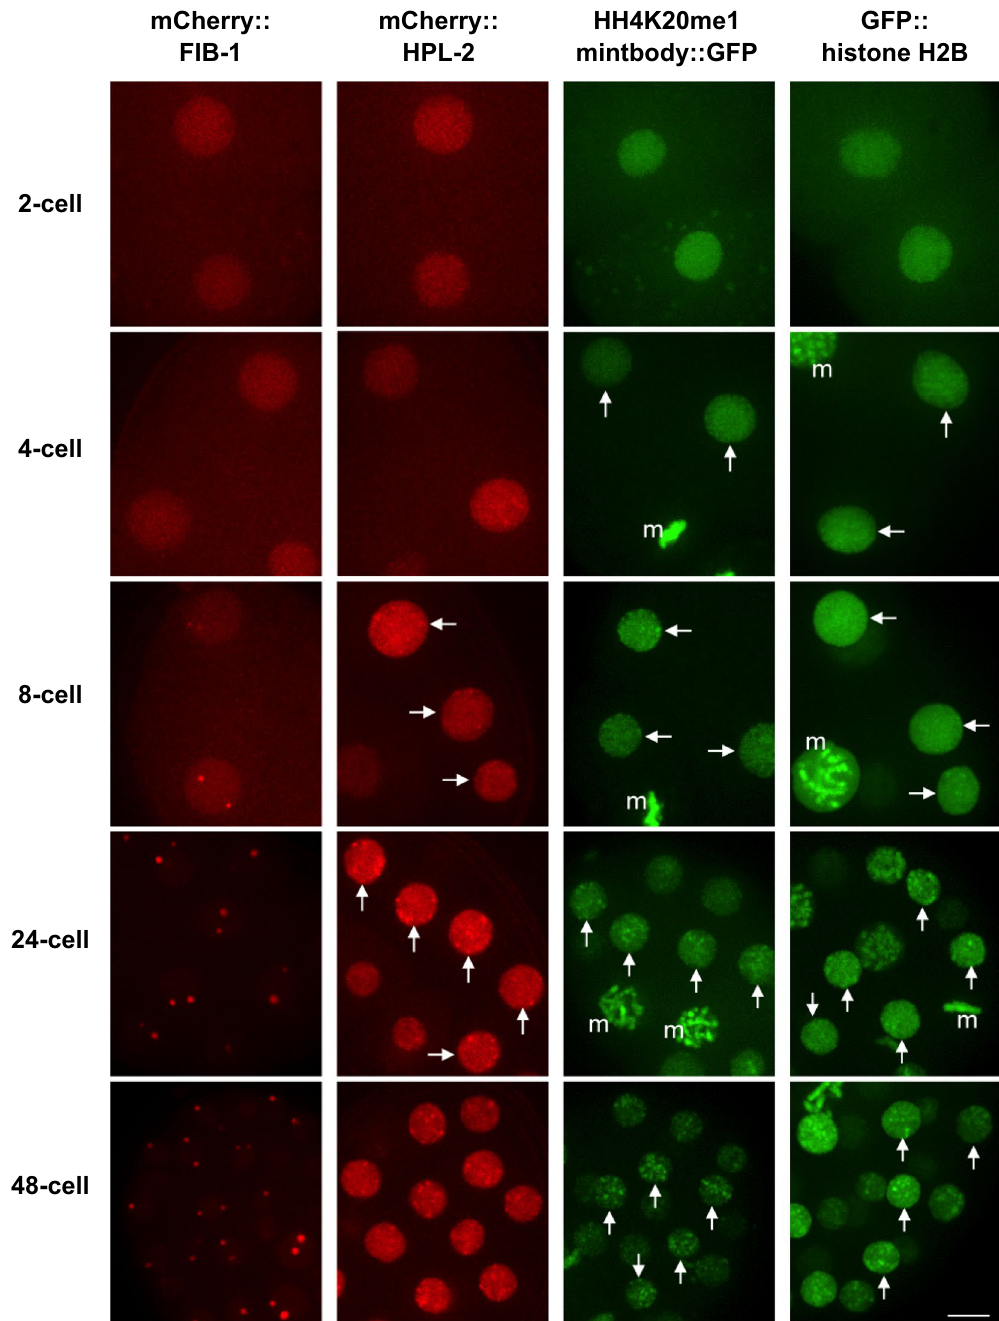
Figure 4. Live imaging of chromosomal domain formation during early embryogenesis. Imaging of FIB-1 (fibrillarin protein, nucleolus marker); HPL-2 (HP1 protein, heterochromatin marker); H4K20me1 mintbody (antibody fragment against mono-methylated lysine 20 of histone H4); and histone H2B. “m” indicates mitotic chromosomes or nucleus. Other signals are from interphase nuclei (arrows indicate representative nuclei). Bar, 5 μ